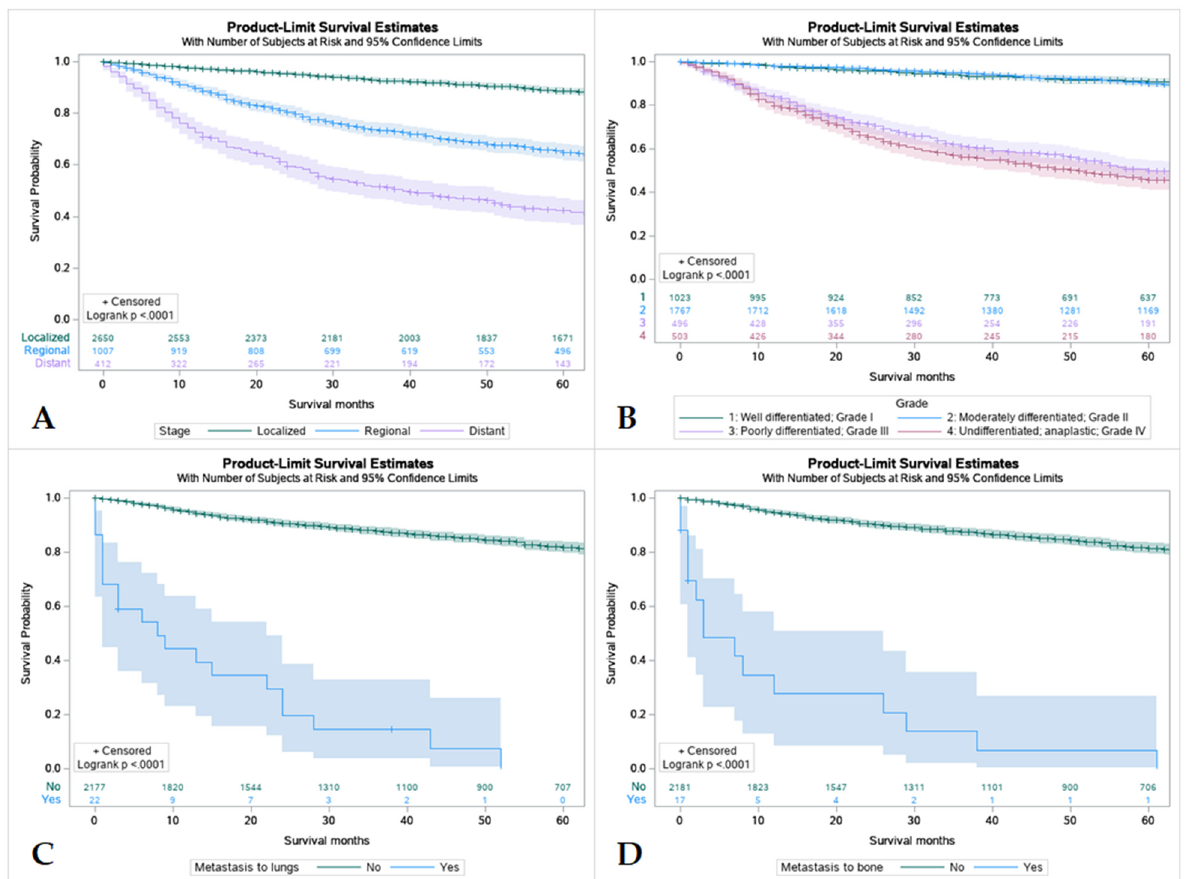
Figure 5. Kaplan Meier graphs displaying comparative survival analysis of 4507 patients with mu- coepidermoid carcinoma (MEC) over the span of 60 months (5 years) by ( A ) Tumor Stage, ( B ) Tumor grade, ( C ) Metastasis to the lung, and ( D ) Metastasis to the bone. Patients with localized tumor staging had higher 5-year survival than regional or distant spread. Well-differentiated (Grade I) and moderately differentiated (Grade II) tumors were found to have higher 5-year survival compared to poorly differentiated or undifferentiated tumors ( p < 0.005). Metastasis to lungs or bone were found to mean statistically lower 5-year survival in patients compared to those without metastasis.